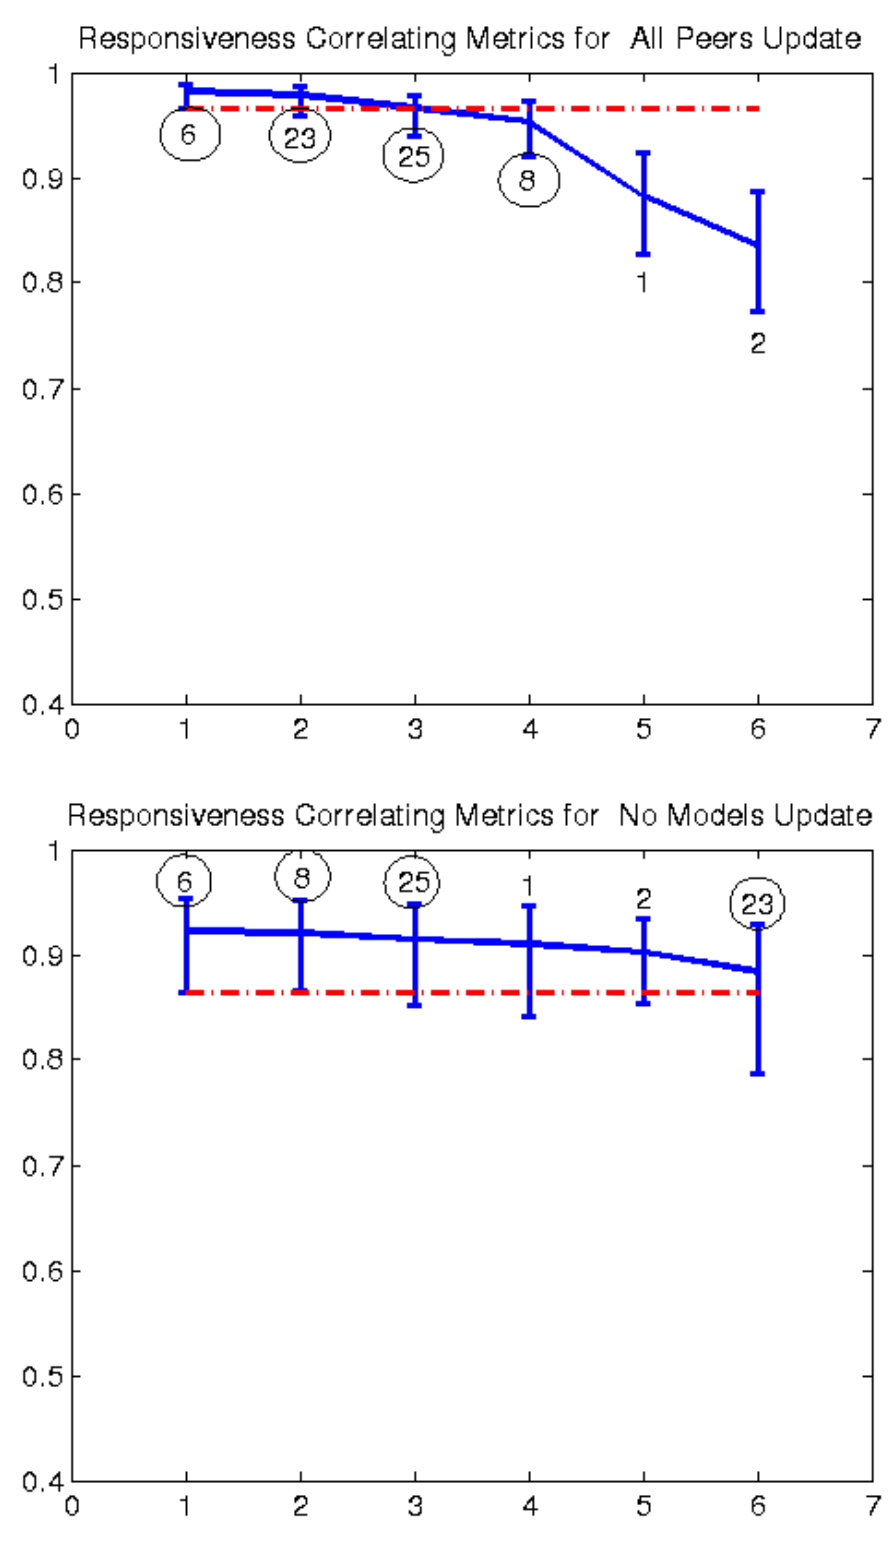
Figure 4. Pearson correlation with responsiveness all peers and no models